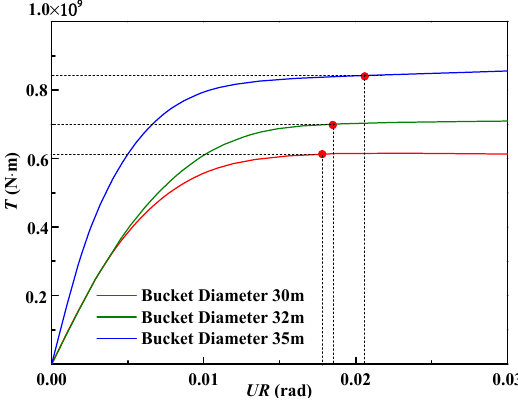
Figure 20. The rotation-torque curves under di ff erent bucket